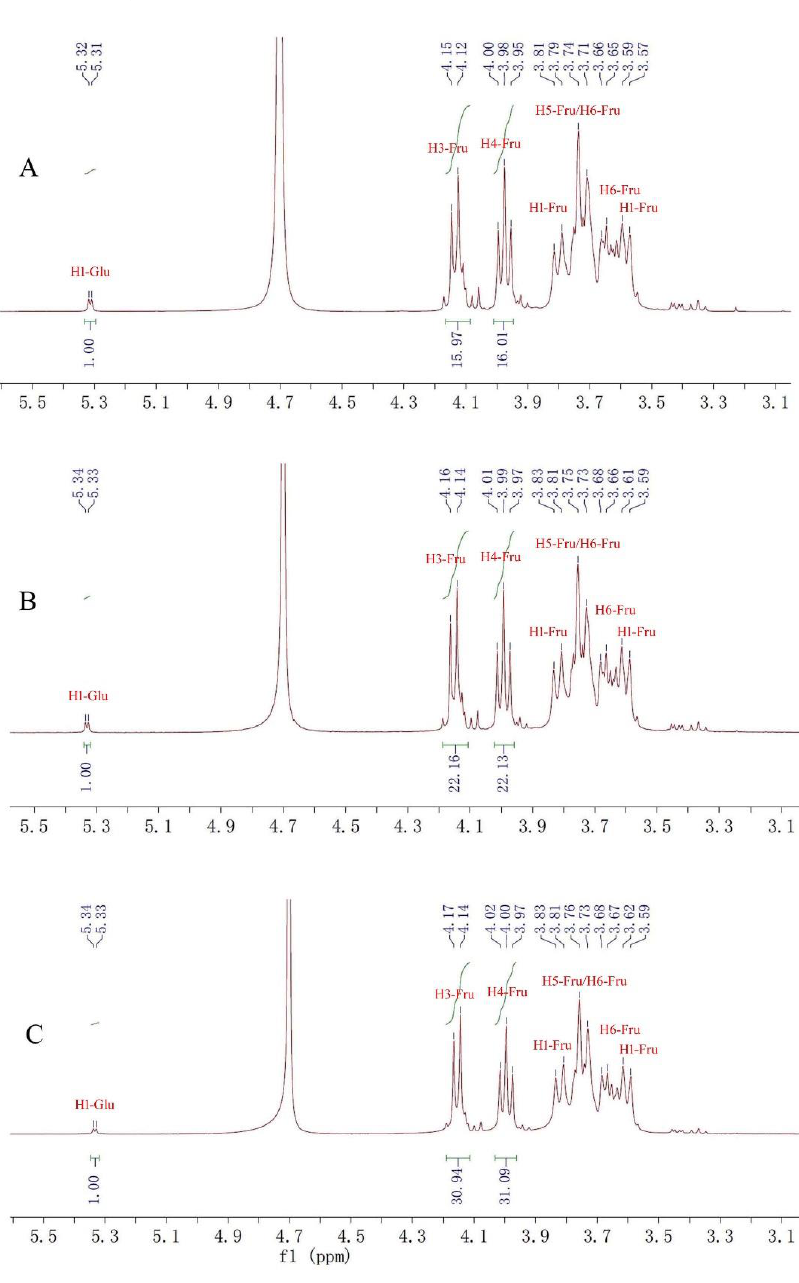
Figure 2. 1 H-NMR spectra of fructans 1 ( A ), 2 ( B ) and 3 ( C ).